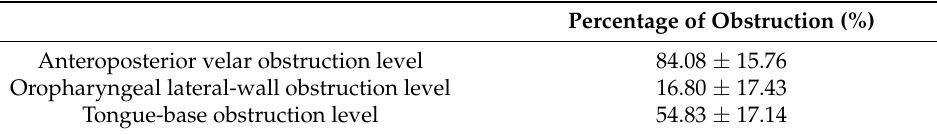
Table 2. Preoperative DISE findings (mean ± standard deviation).